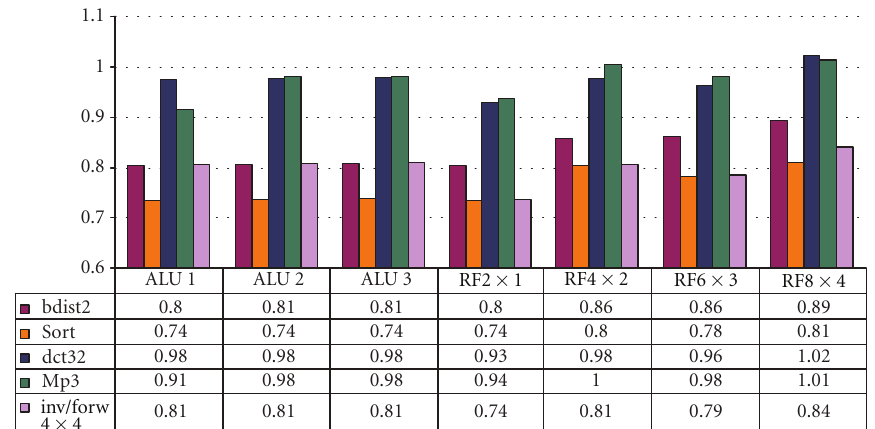
Figure 11: Relative cycle time for pipelined data paths generated for di ff erent resource constraints.